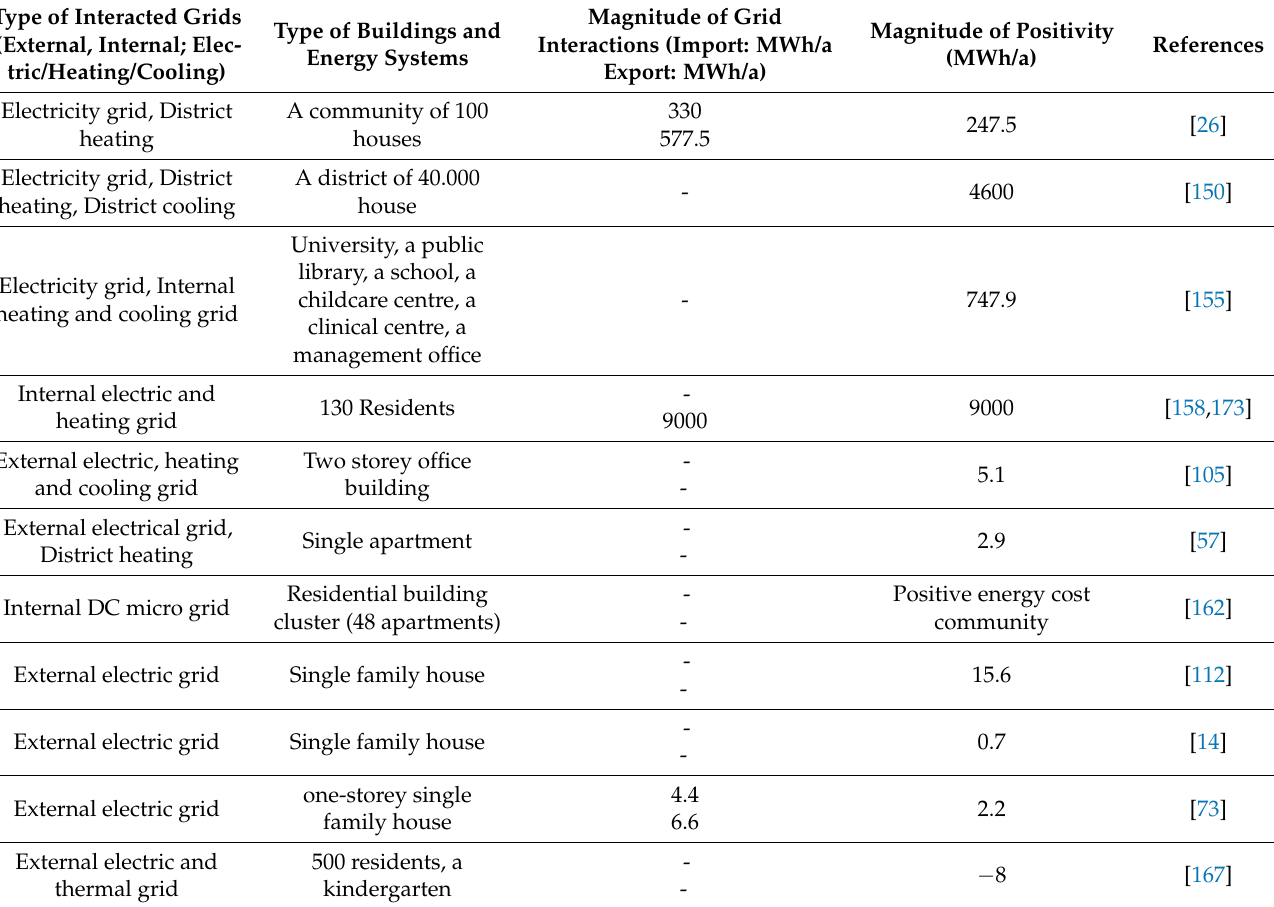
Table 8. Impact of smart energy grid on PEB and